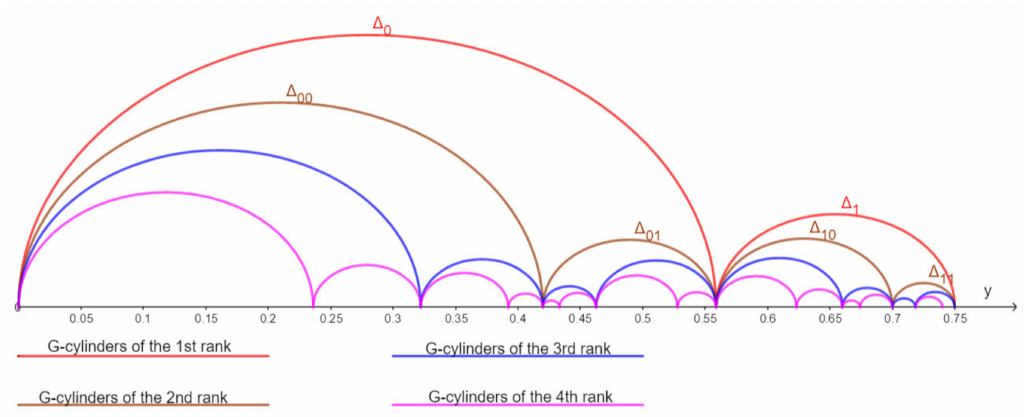
Figure 11. The image of the plural C 1